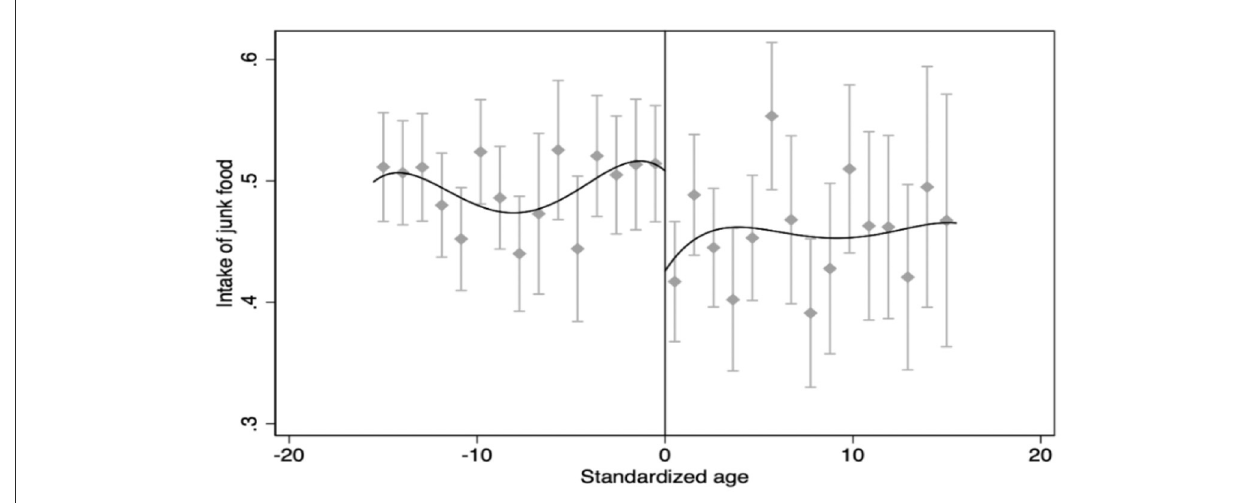
FIGURE2 The results of the FRD. Source: CFPS2014 and Stata 16.0.